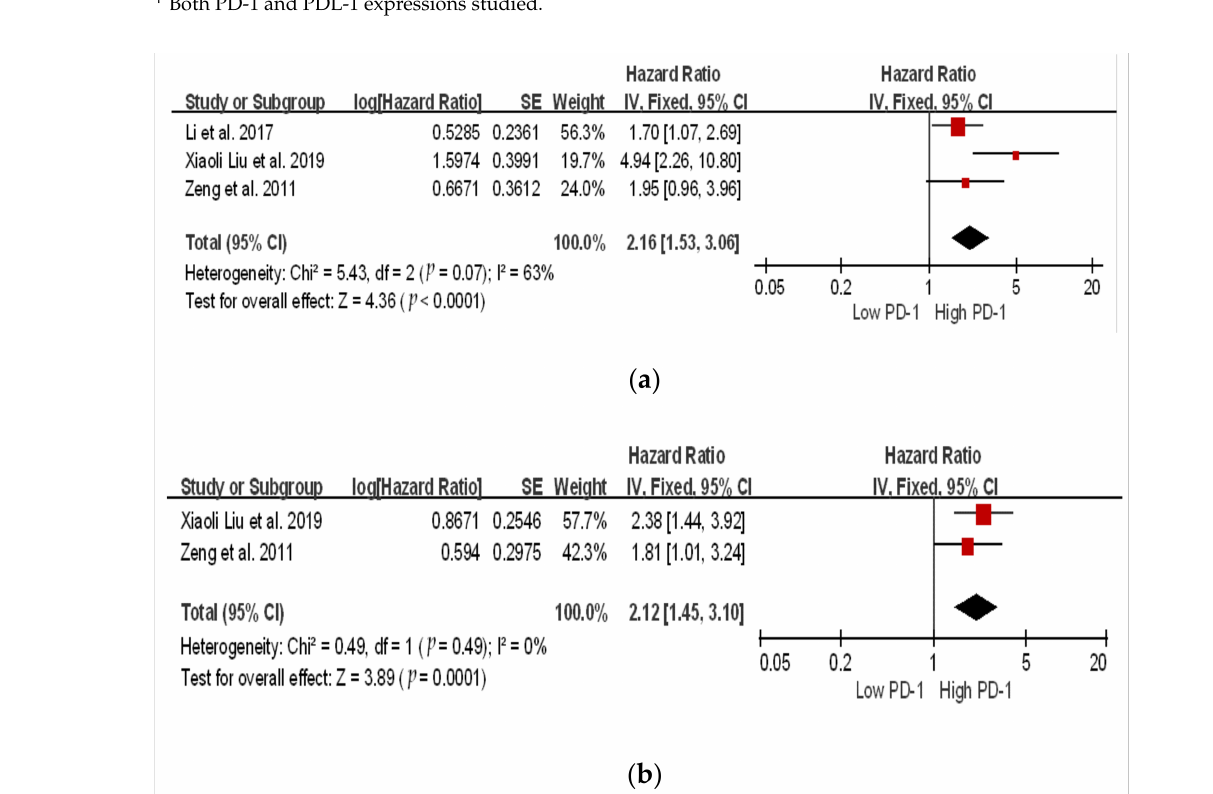
Abbreviations: CD8, cluster of differentiation 8; DFS, disease-free survival; ELISA, enzyme-linked immunosorbent assay; IHC, immunohistochemistry; PD-1, programmed death protein 1; PDL-1, programmed death ligand-1;